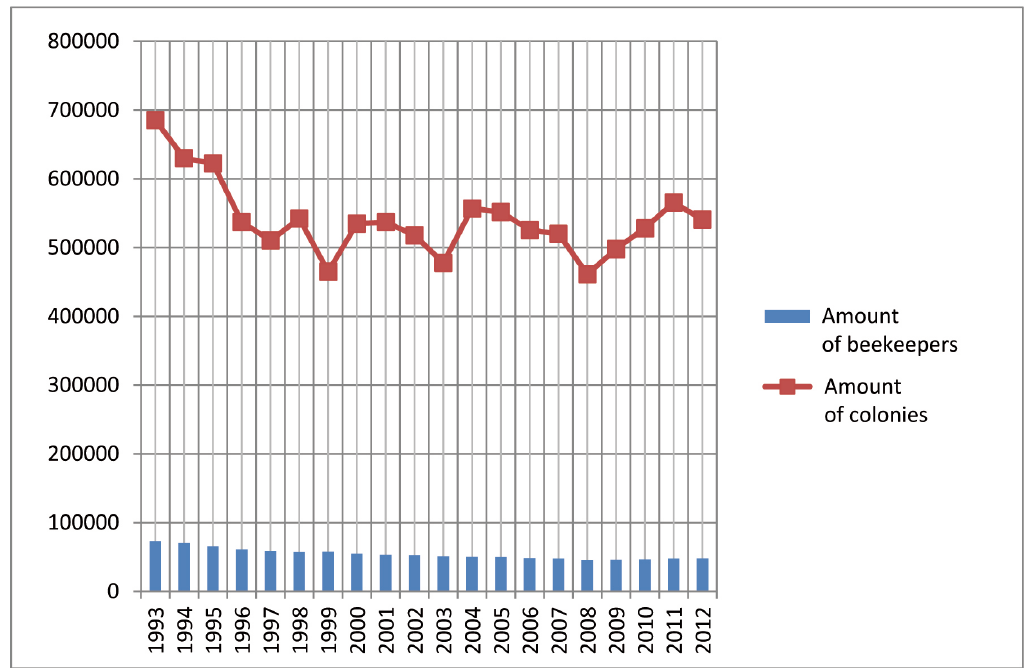
Fig. 1. Number of beekeepers and number of bee colonies in the Czech Republic since 1993 (Situational and outlook report on bees, November 2013)